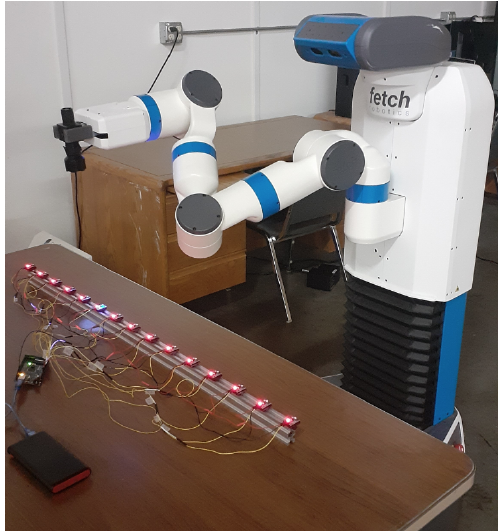
Figure 4. A Fetch robot hovering UV flashlight above UV sensor array.